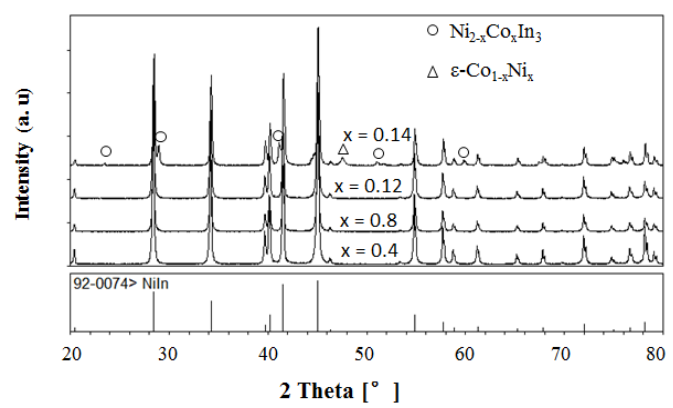
Figure 8. XRD patterns of the sample Ni 1 − x Co x In (x = 0.04, 0.08, 0.12, 0.14).